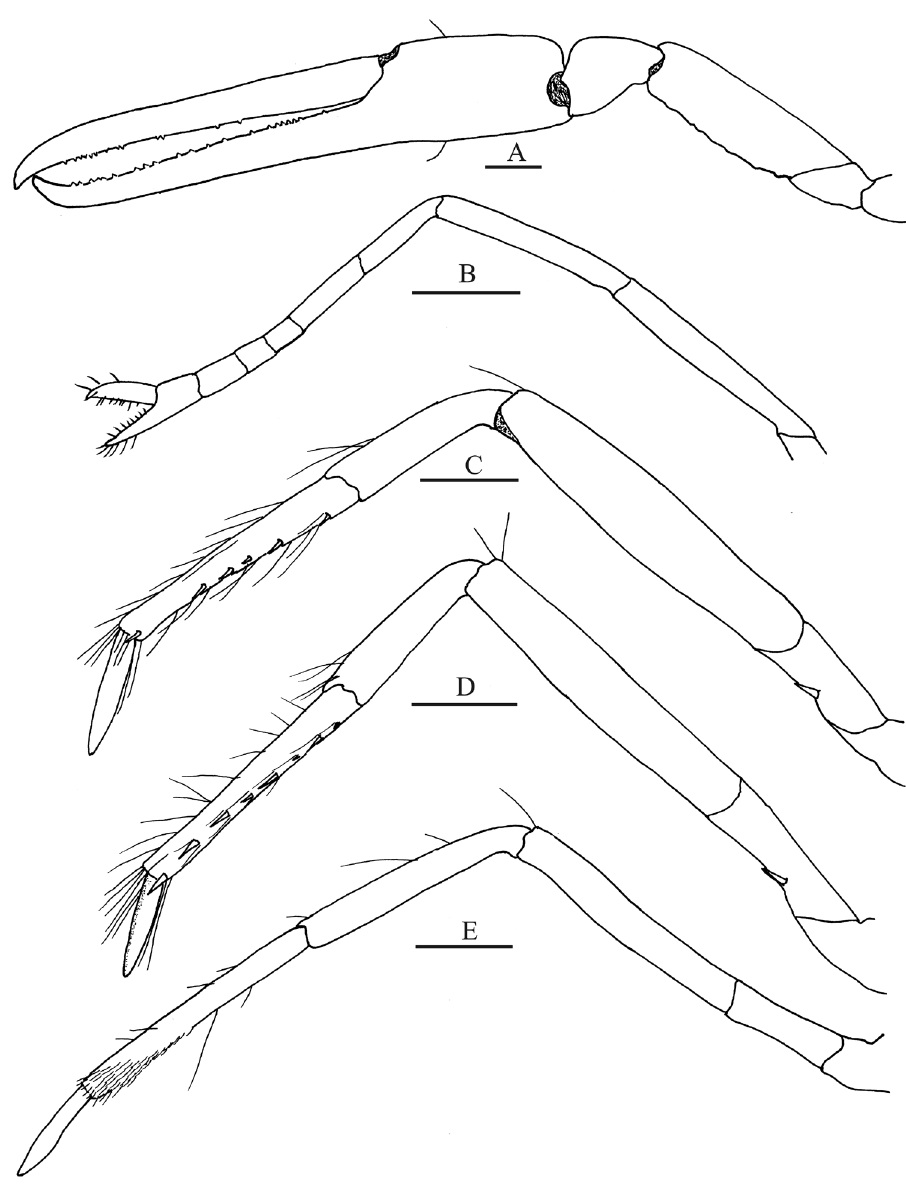
Figure 4. Alpheus margaritae sp. n. Female paratype, CL 7.4 mm, (EMU-10581); A minor first pereo- pod, mesial view B left second pereopod, lateral view C left third pereopod, lateral view D left fourth pereopod, lateral view E left fifth pereopod, lateral view. Scale bars 1